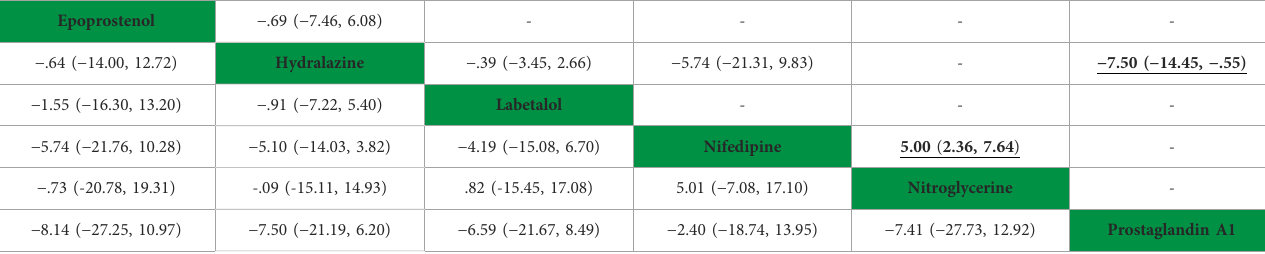
TABLE 6 Network comparison and direct comparison results for diastolic blood pressure (mmHg). Epoprostenol